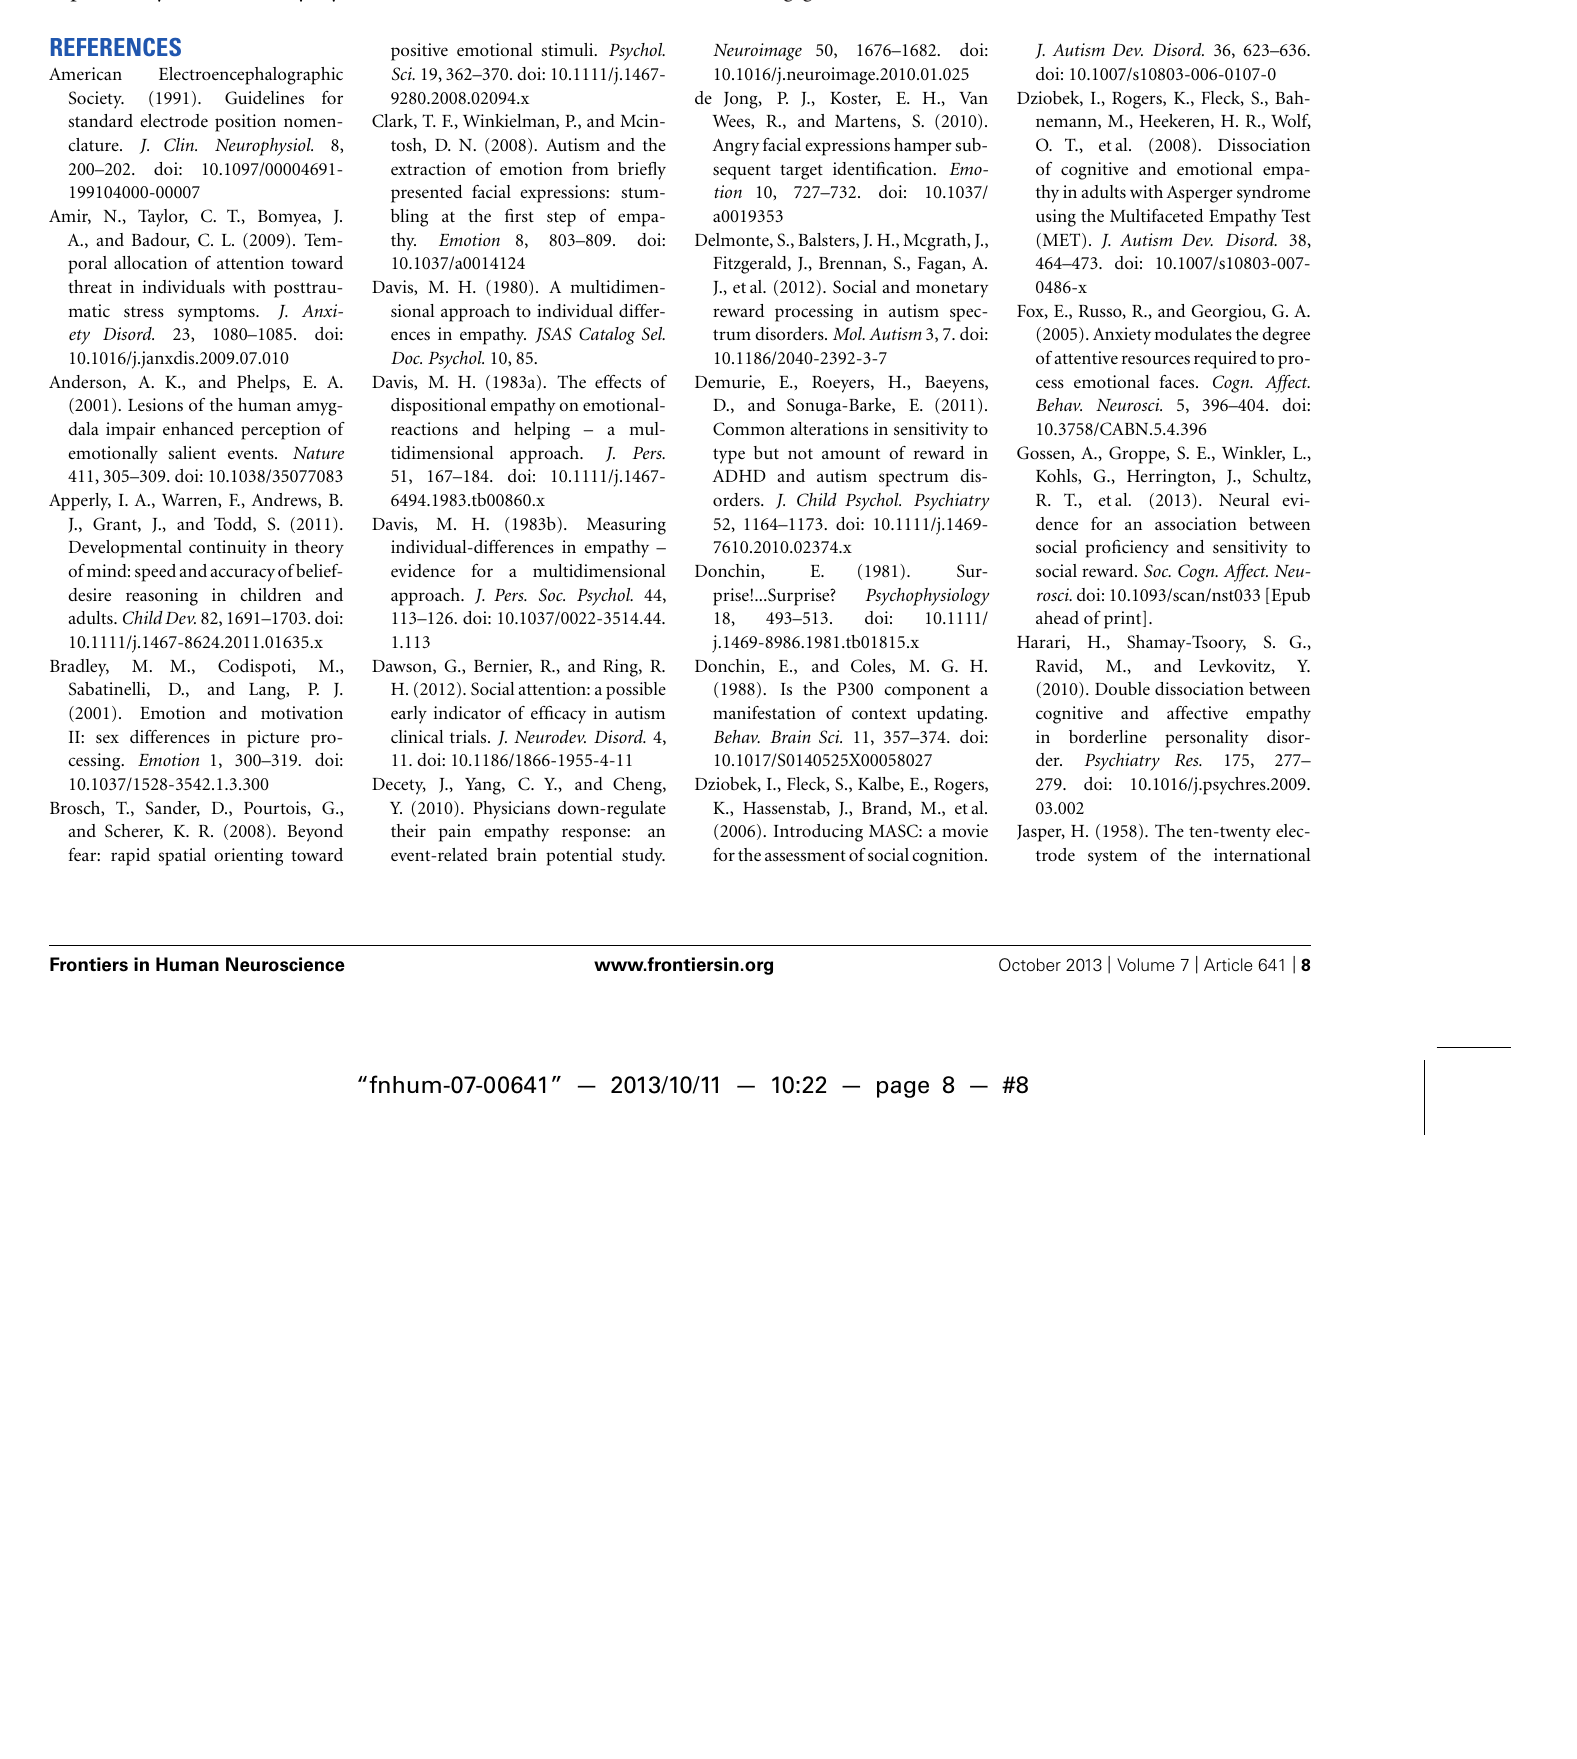
blink with pictorial stimuli. Emotional stimuli are salient